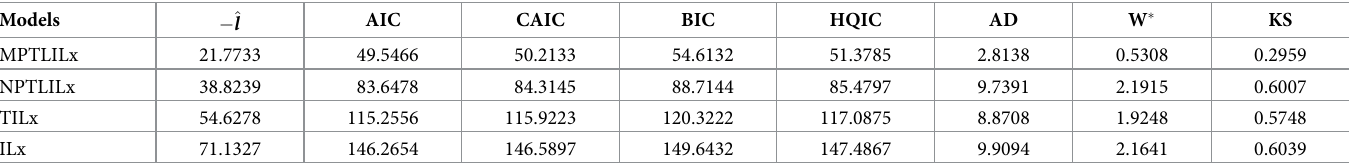
Table 5. The information criteria results for the thickness of electronic devices data.